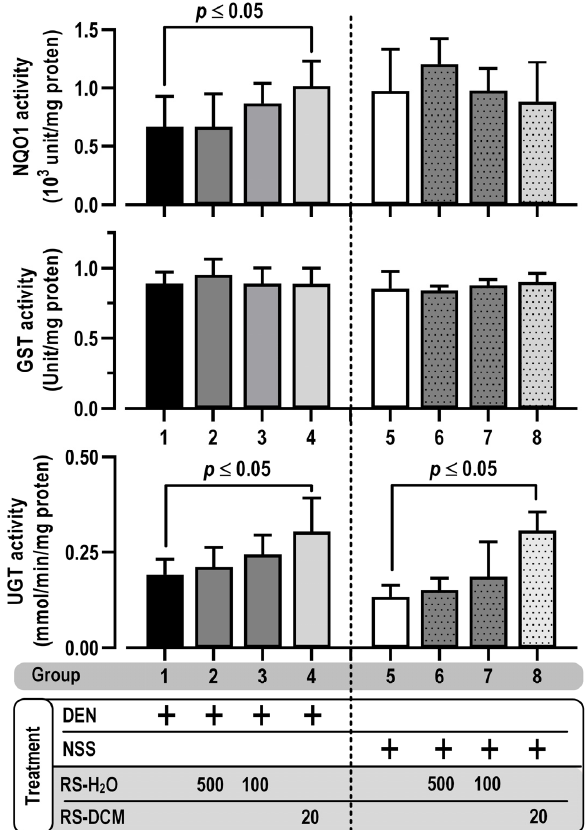
Figure 7. The e ff ect of RS on phase II metabolizing enzymes: UGT, GST, and NQO1. The values are expressed as mean ± SD. The data were distributed normally (Shapiro–Wilk: p > 0.05) and were analyzed for statistical signi fi cance using one-way ANOVA with LSD’s post hoc test. RS dosage unit is mg/kg BW.